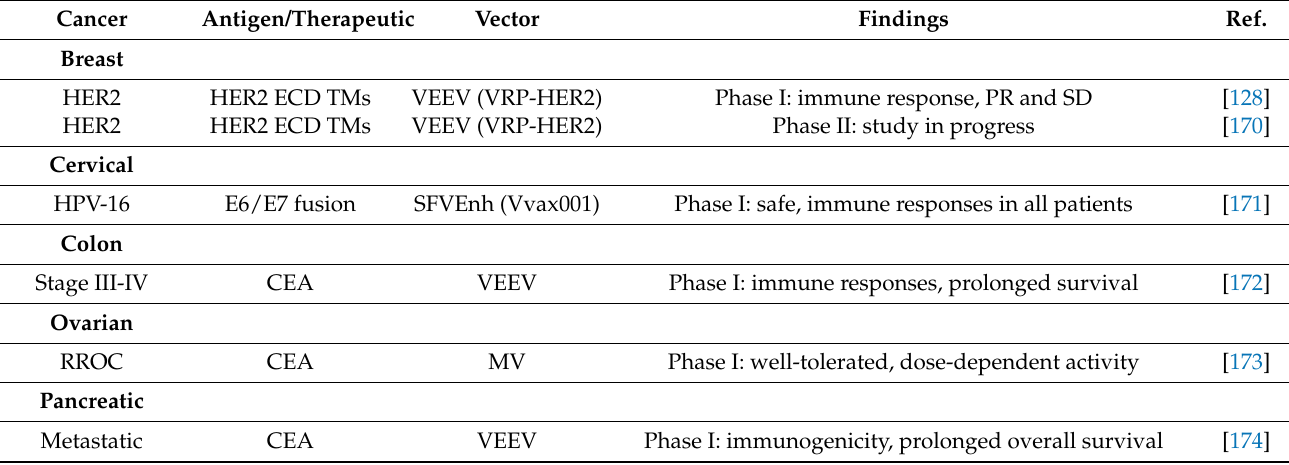
Table 4. Examples of clinical studies on self-replicating RNA viral vector vaccines against